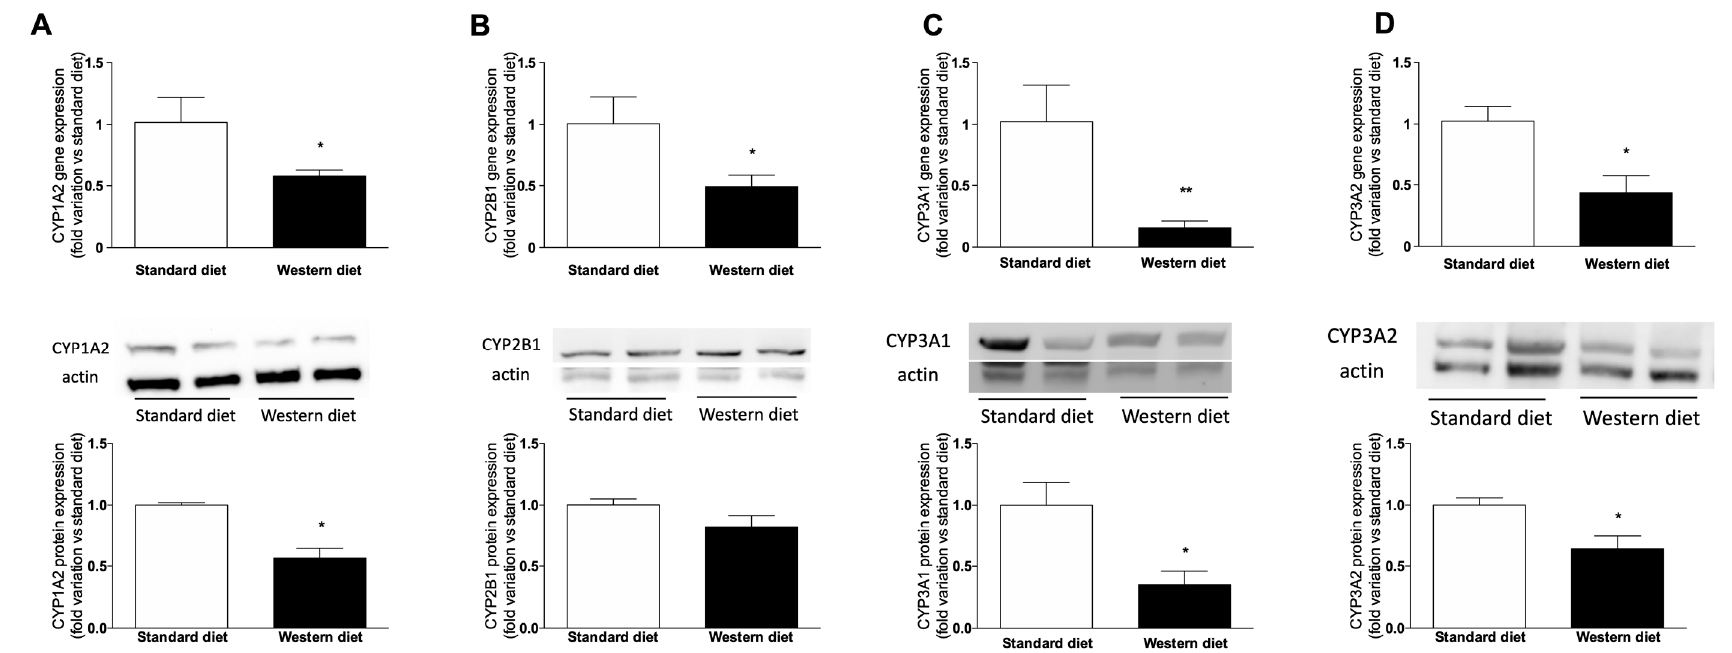
Figure 7. mRNA and protein expression of CYPs. mRNA (upper panel) and protein (lower panel) expression of CYP1A2 ( A ), CYP2B1 ( B ), CYP3A1 ( C ) and CYP3A2 ( D ). Between graphs, representative western blot analyses have been reported. The analysis was performed on cell lysates obtained from eight animals per group. * p < 0.05, ** p < 0.01 vs. rats fed with standard diet.